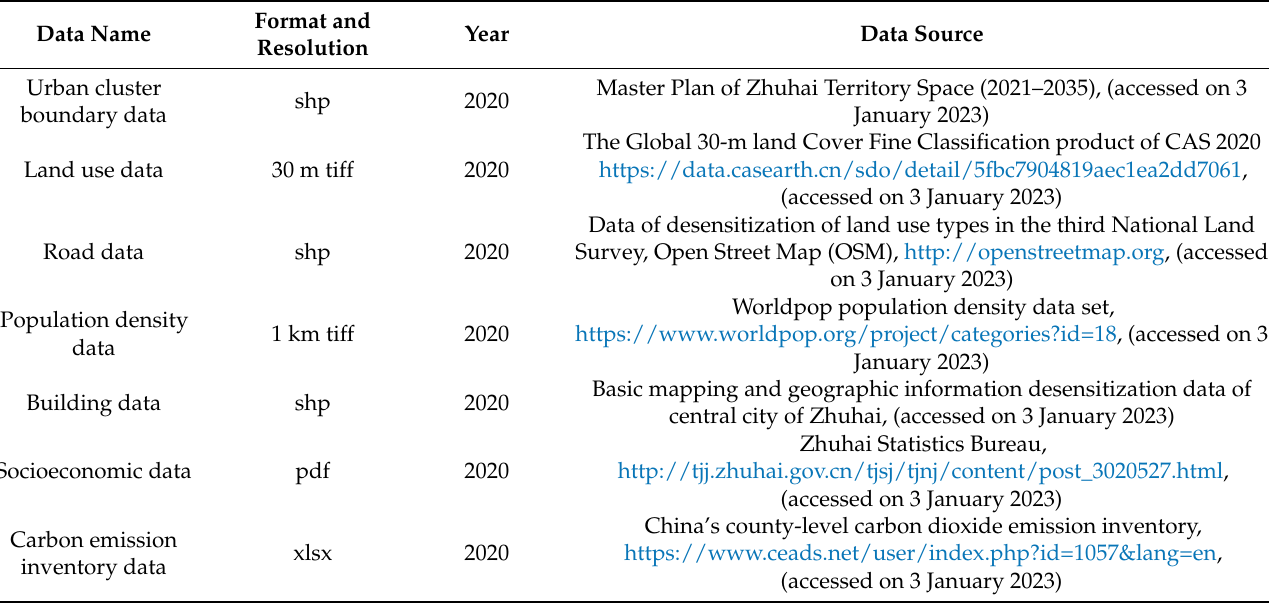
Table 1. Basic data list.